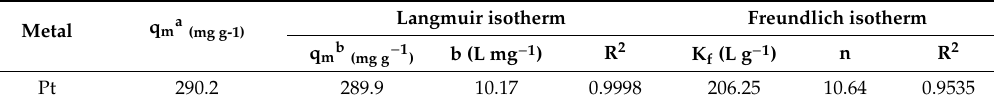
Table 3. Langmuir and Freundlich isotherm parameters of TEBAC-HKUST-1.